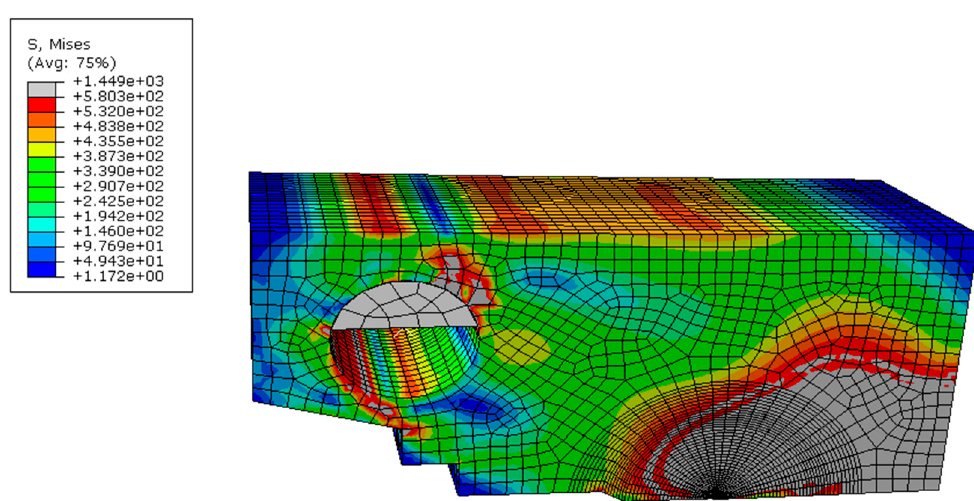
Figure 4. An example of stress distribution in 1CT specimen at 182 K.